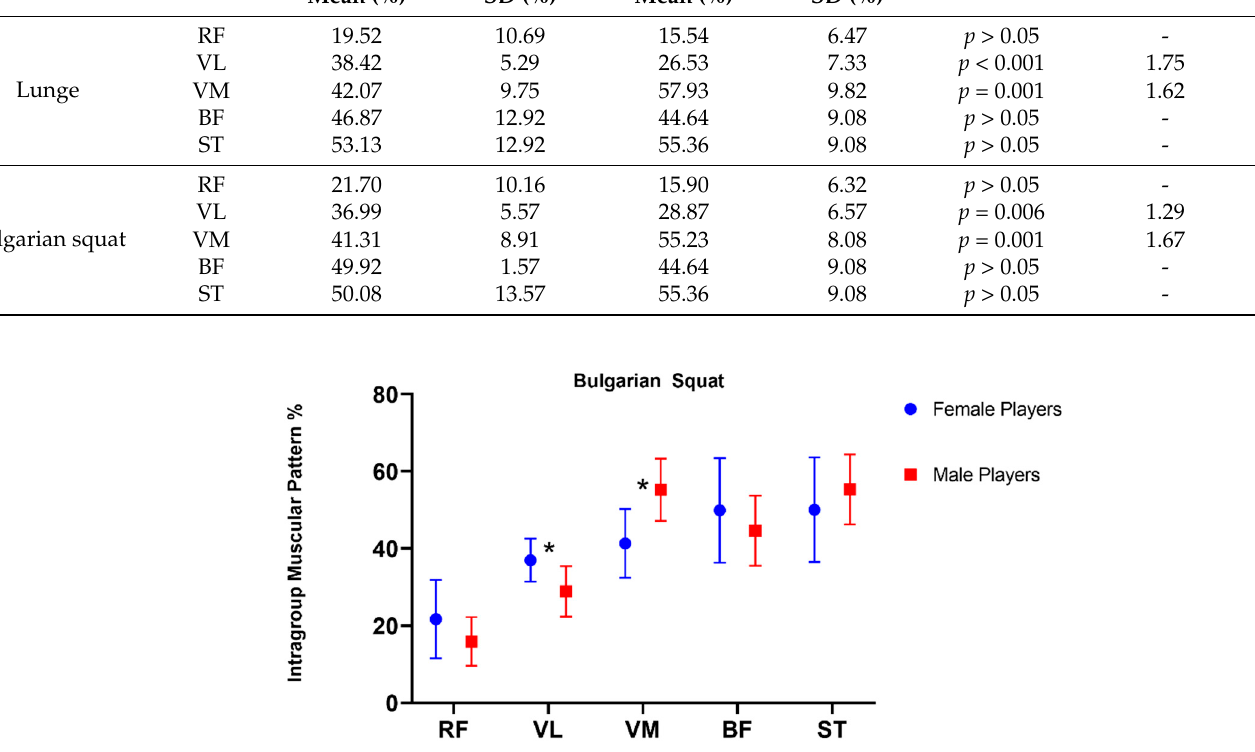
Figure 3. Intragroup muscular pattern (mean ± SD) in percentage. The intragroup muscular pattern expresses the activation of each muscle belly in relation to the total muscle (quadriceps and hamstrings). The asterisk (*) shows that there is a significant difference. Table 3. Intragroup muscular pattern in percentage.